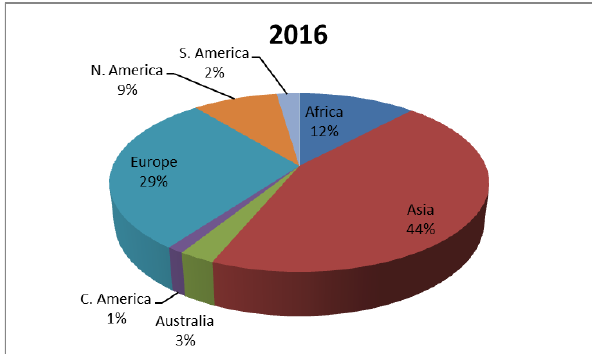
Figure 5. Percentage of members by geographical region for 2016.